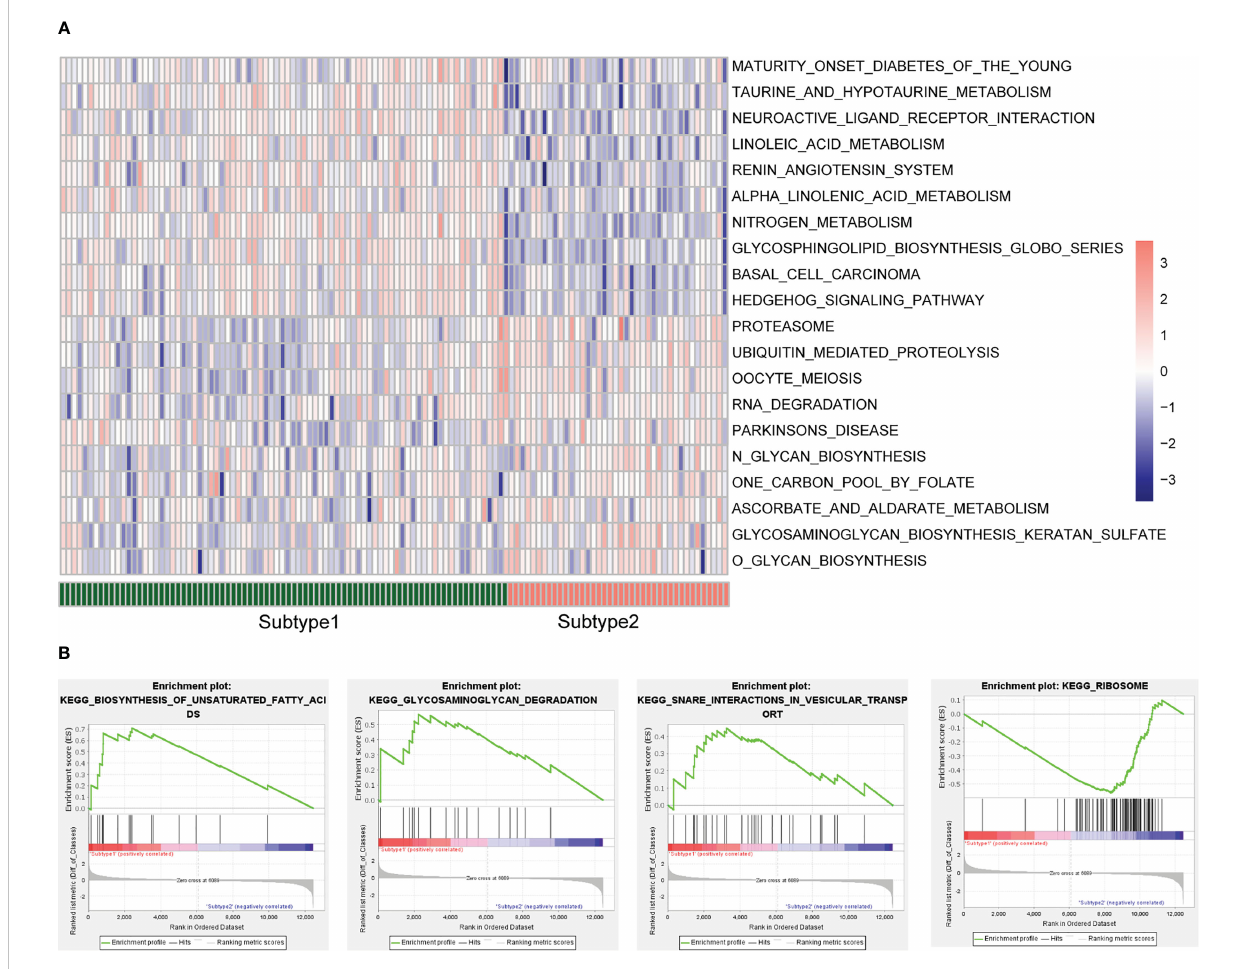
FIGURE 7 Enrichment analysis between the two subtypes. (A) GSVA enrichment analysis. (B) GSEA enrichment